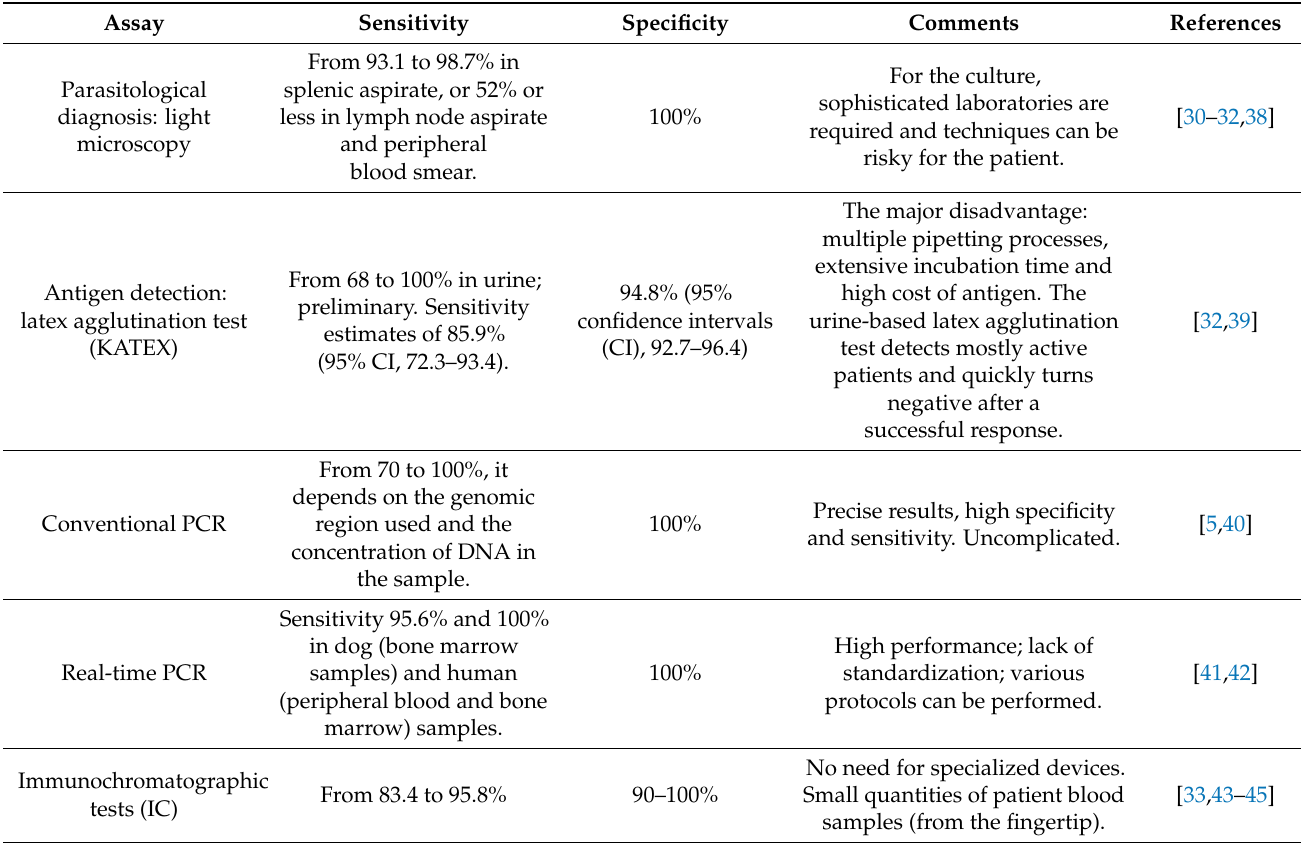
Table 1. Various assays for leishmaniasis diagnosis